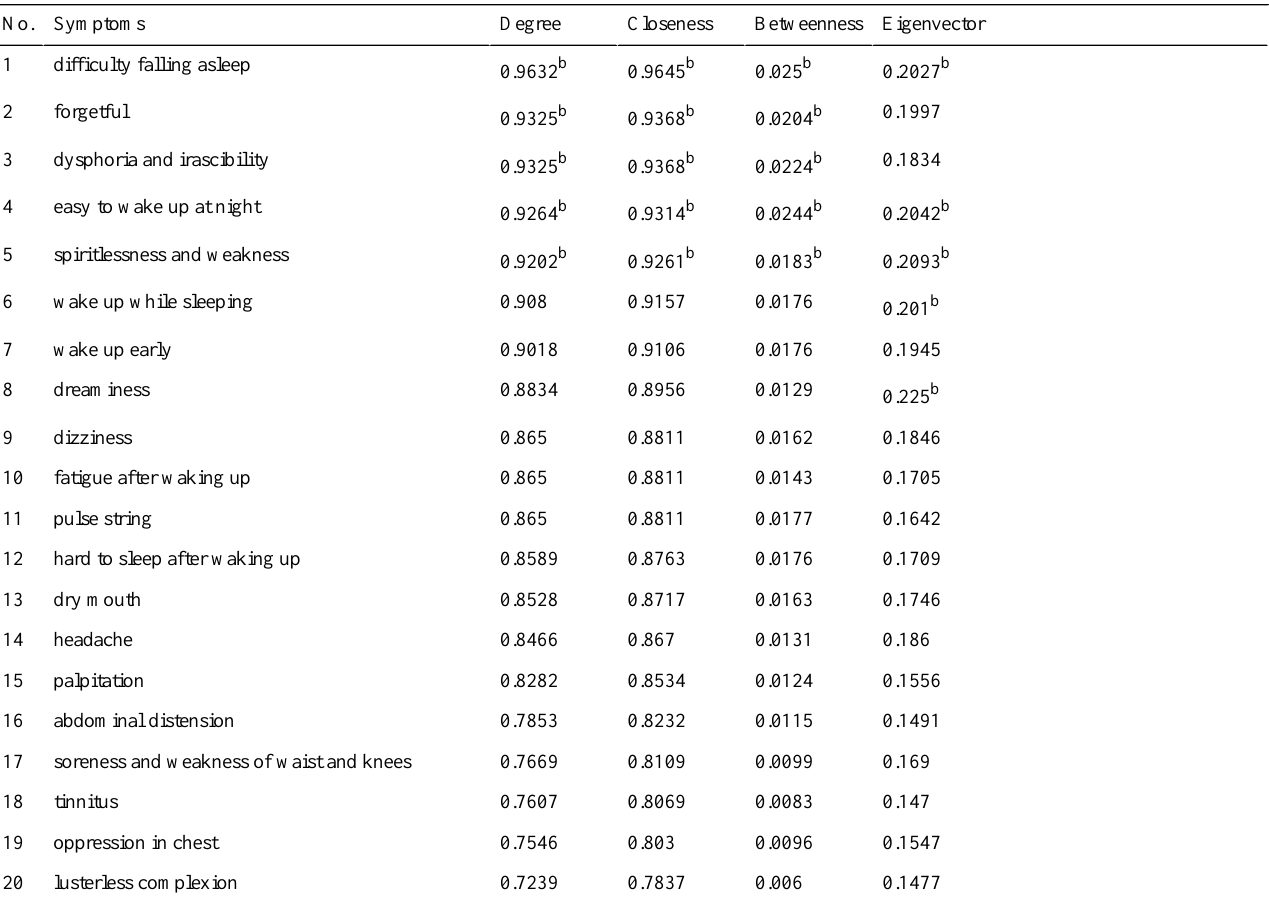
Table 1. Node centrality analysis of the symptom network a . EigenvectorBetweennessClosenessDegreeSymptomsNo.